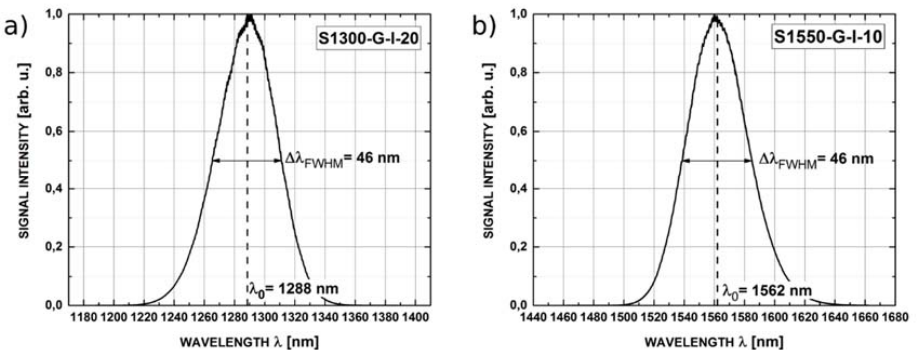
Figure 4. Intensity for implemented superluminescent diodes with marked center wavelength ( λ 0 ) and full width at half maximum ( Δλ FWHM ) for: ( a ) S1300-G-I-20; ( b ) S1550-G-I-10.